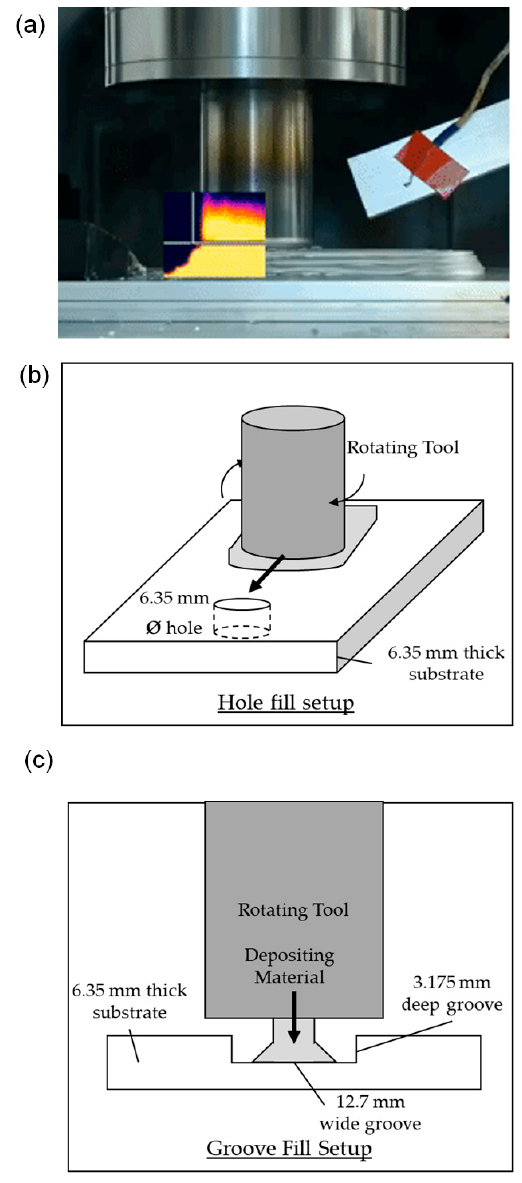
Figure 1. ( a ) Example of the additive friction stir deposition process; ( b ) schematic of the hole filling method conducted; ( c ) schematic of the groove filling method conducted.